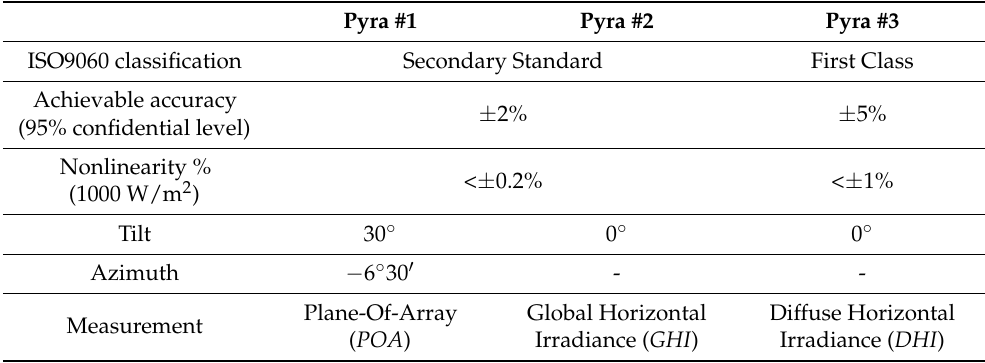
Table 1. Technical specifications of pyranometers connected to the weather station and available at the test